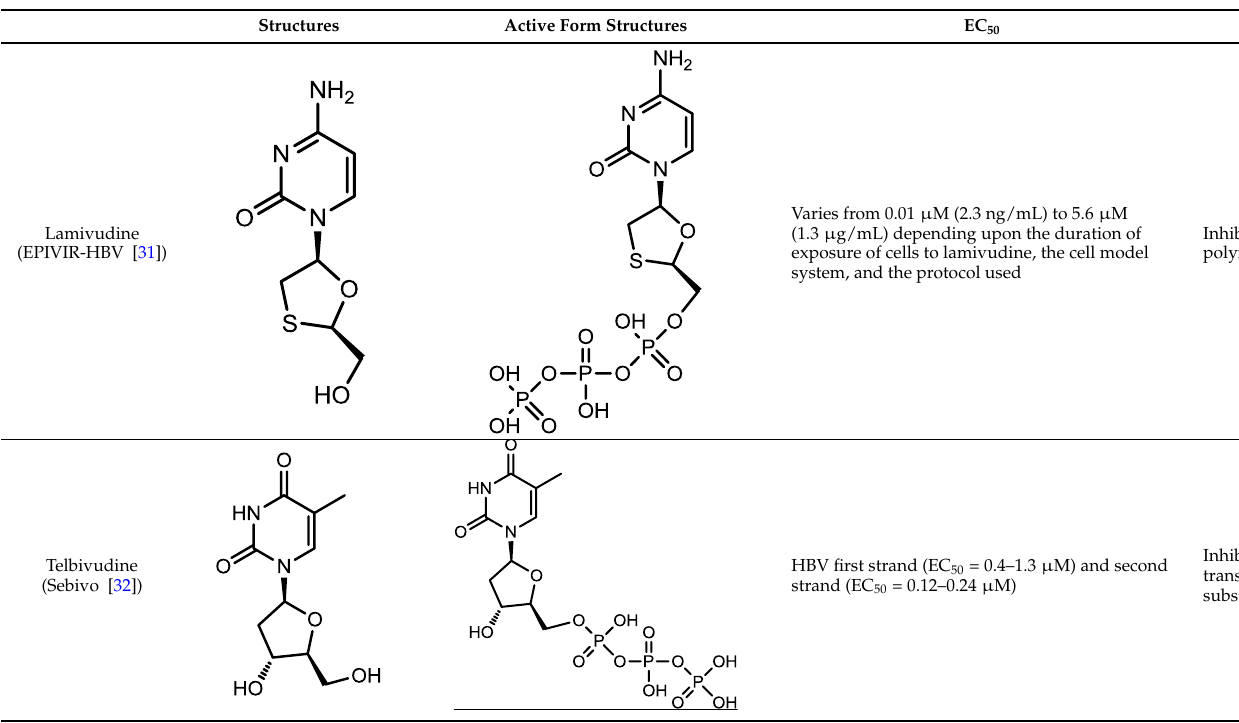
Table 1. Summary of the structures of the anti-HBV drugs.